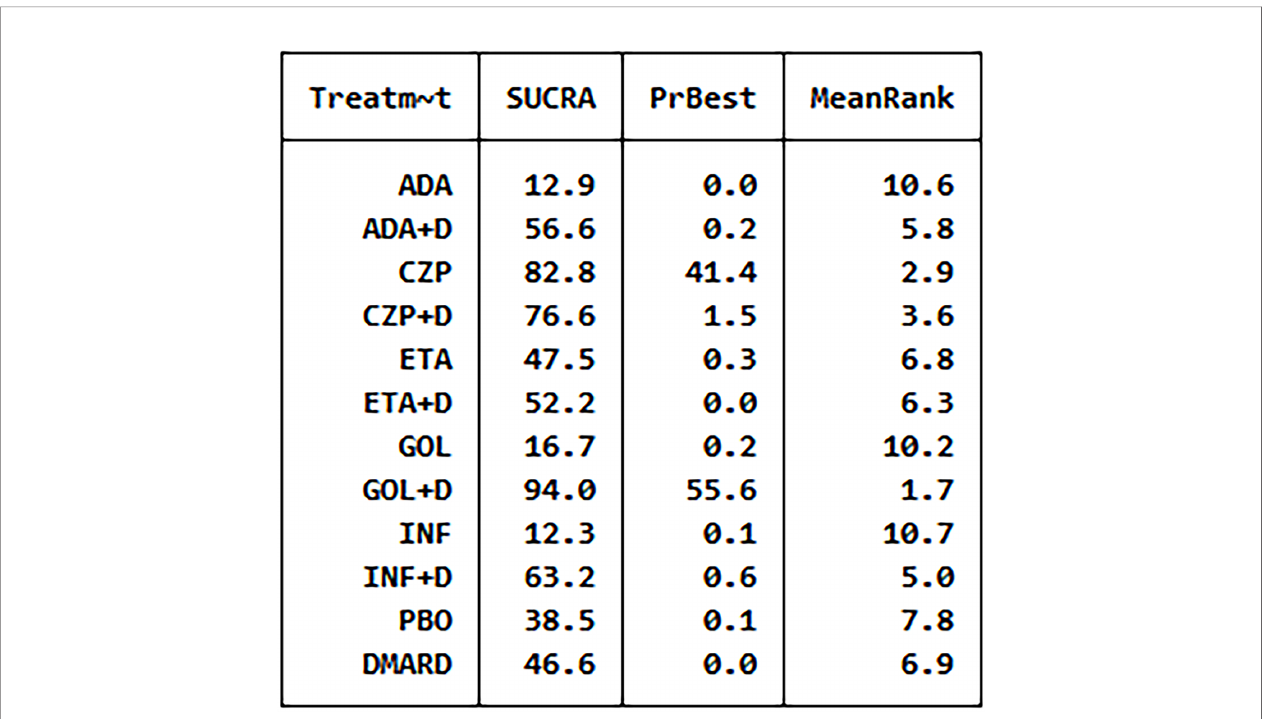
FIGURE 6 | The analysis SUCRA of serious adverse events for 12 therapies. ADA, adalimumab; + D, plus DMARD; CZP, certolizumab; ETA, etanercept; GOL, golimumab; INF, in fl iximab; PBO, placebo; DMARD, disease-modifying anti-rheumatic